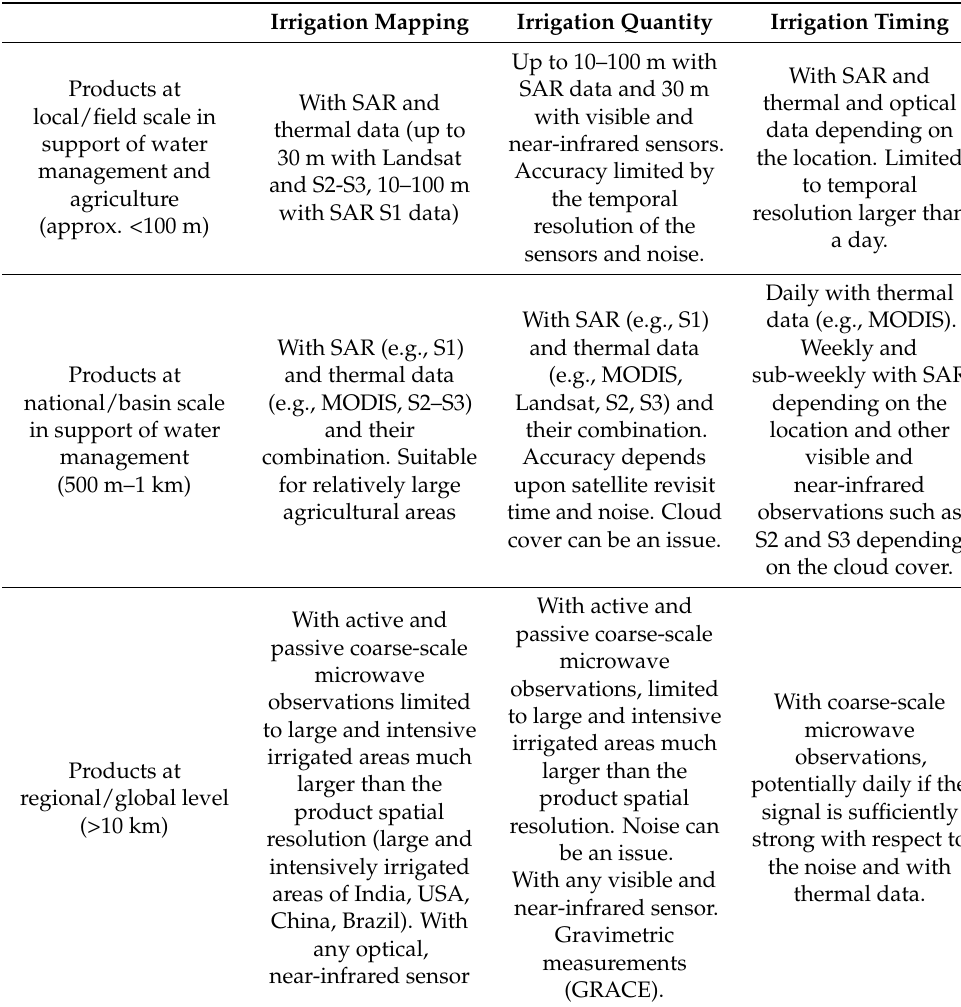
Table 2. Potential of satellite-based remote sensing observations to detect irrigation information from space as a function of the scale of